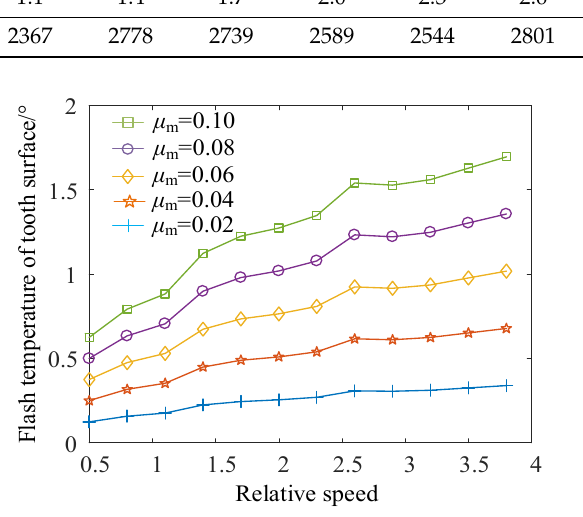
From Figure 16, it can be observed that the abscissa is the relative speed of the gear